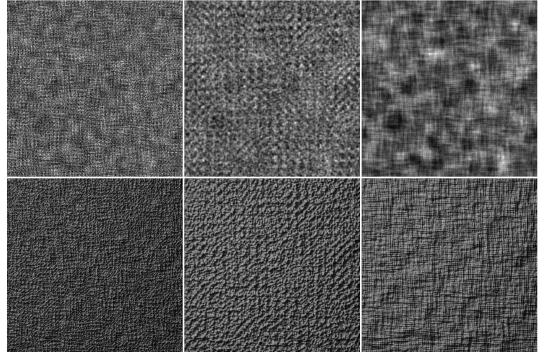
Figure 10. Textures generated with wavelet noise. First, row: height maps. Second row: relighting